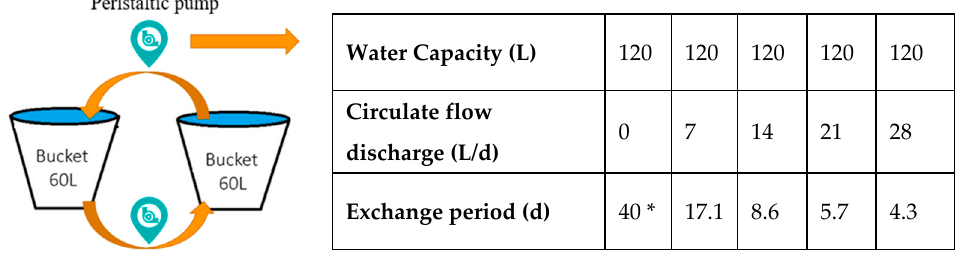
Figure 1. Experiment setup and flow exchanges. * refers to the experimental